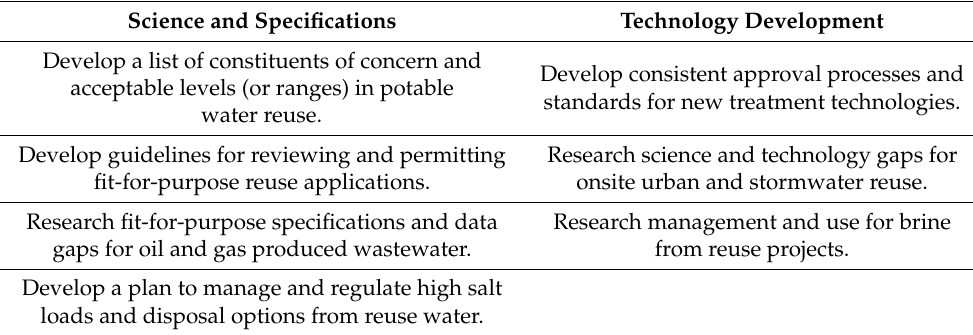
Table 3. Summary of some actions from the National Water Reuse Action Plan in the United